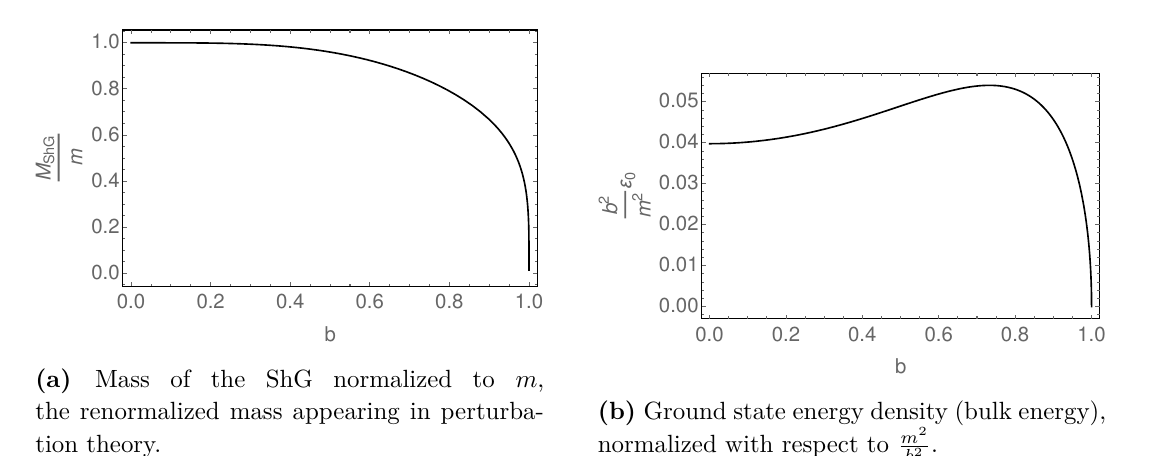
Figure 4. Mass and ground state energy of the ShG